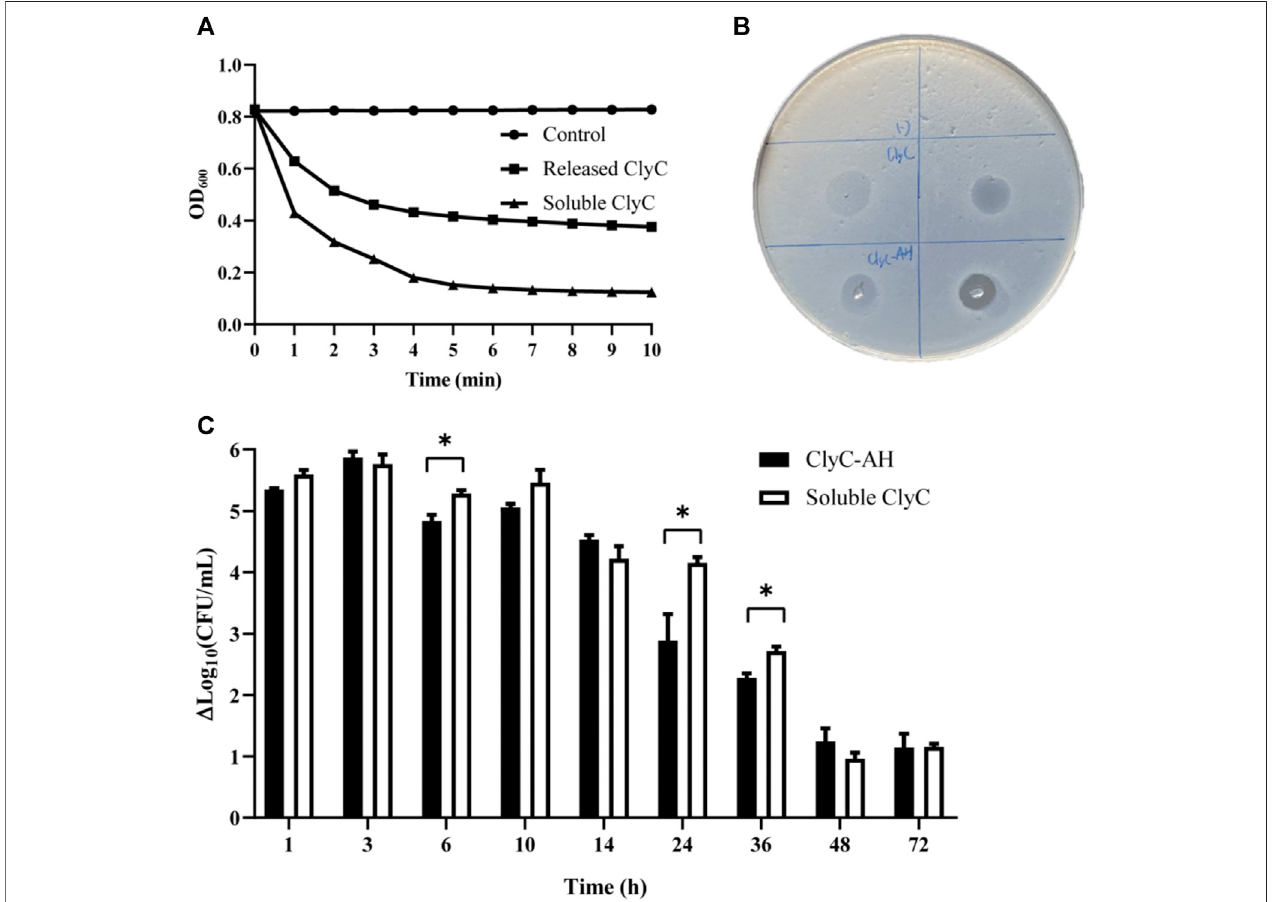
FIGURE5| Thebactericidaleffectofblankhydrogel, ClyC-AH (250 µg/ml), andfreeClyC(125 µg/ml) wasquanti fi ed byincubatingthe S.aureus T23. (A) Turbidity reductionexperiment,thelyticactivityofClyCandreleasedClyCafterincubated3 hin37 ° Cincubator; (B) inhibitionzoneassayresultshowingClyCandClyC-AHactivity against S.aureus T23; (C) Brie fl y, S.aureus T23cellsat acelldensity ofapproximately 10 8 CFU/mlwereincubated withdifferenttimeofsamplefor1 hat 37 ° C.Thelytic potentialwasassessed basedonadecrease inbacterial logcountcomparewithblankhydrogel after1 h oftreatment.Andthecalculatedresult ofthereduction of log 10 in viable cell number ( Δ Log 10 CFU/mL). Student ’ s t test, Mean ± SD, n (cid:2) 3 per group, * p <